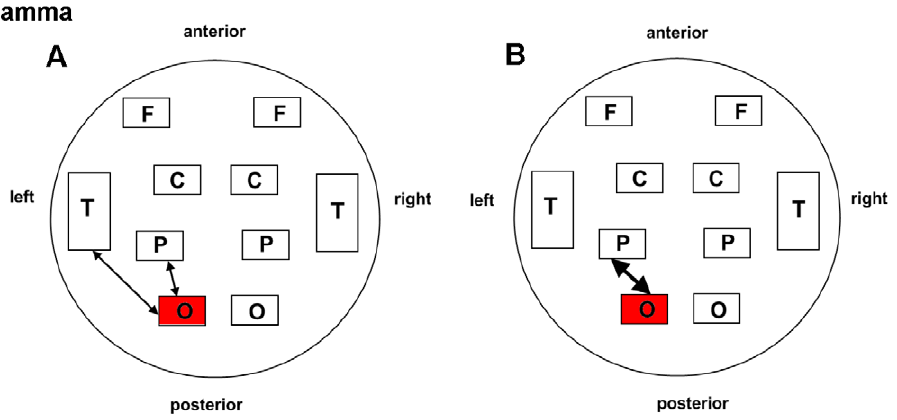
Figure 5. Schematic illustration of BLP correlation alterations for the gamma band. A. ST36 group. B. NAP group. Lines correspond to significant changes for the average Band-Limited Power (BLP) correlation induced by acupuncture and squares to significant change in the local BLP correlation (red: local increase in the BLP correlation following acupuncture; thin line: P , 0.05; thick line: P , 0.01; significance is based upon a paired t -